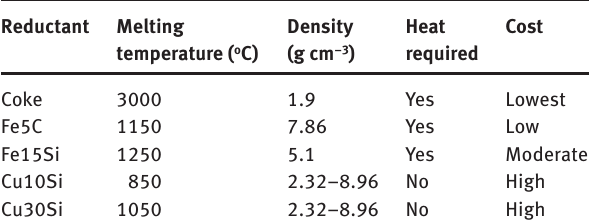
Table 1: Reductant evaluation criteria. Reductant